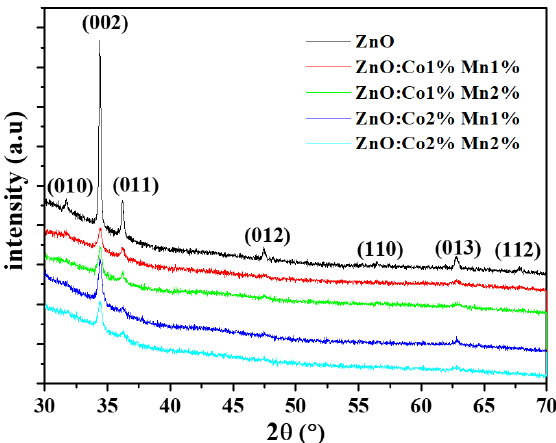
Figure 1. X-ray di ff raction XRD spectra of the undoped and (Co, Mn) co-doped ZnO samples for Figure 1. X-ray diffraction XRD spectra of the undoped and (Co, Mn) co-doped ZnO samples for di ff erent (Co, Mn) different (Co, Mn) contents.